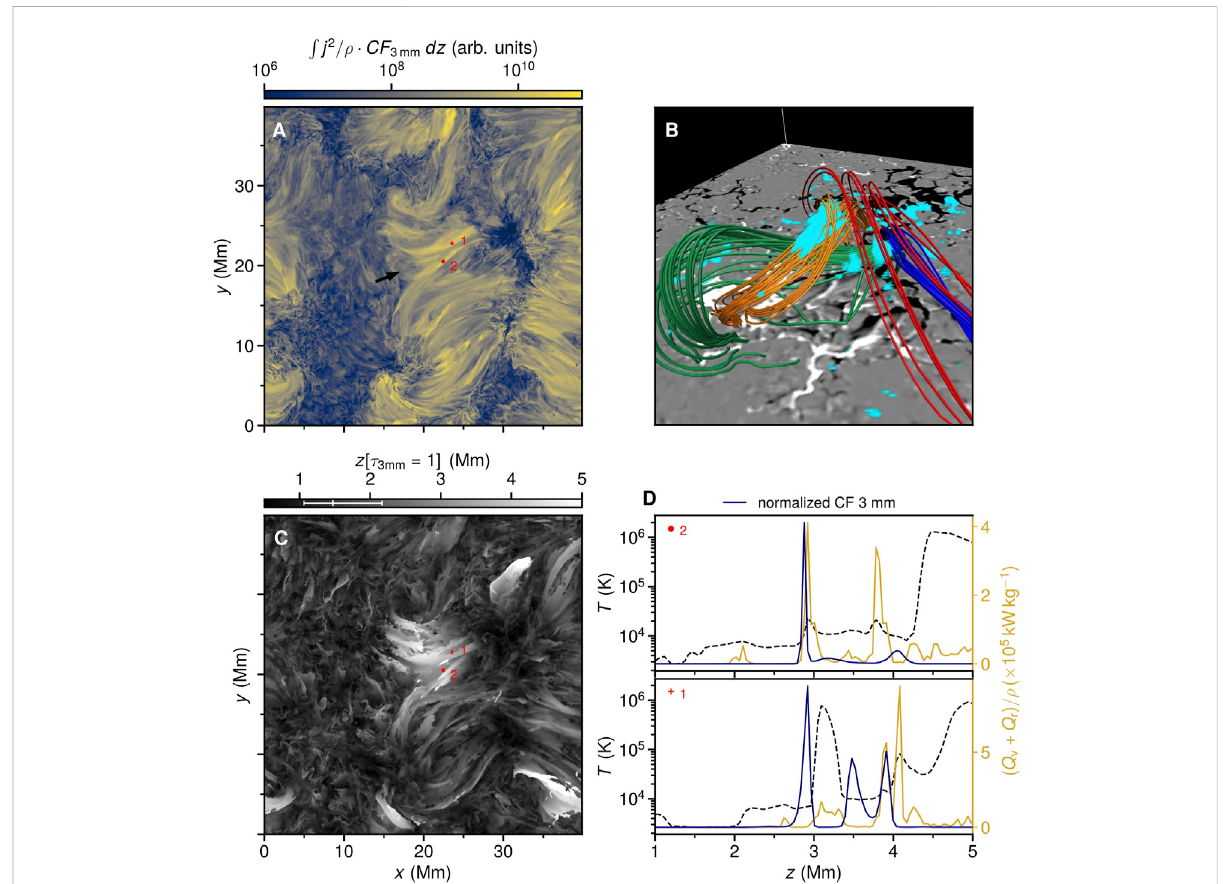
FIGURE 9 (A) Integrated j 2 / ρ weighted by the contribution function of the Band 3 emission (CF3mm); (B) Extrapolated magnetic fi eld lines overlying photospheric magnetogram with the CF3mm depicted with blue shade from the region indicated by the arrow in (A) ; (C) heights of formation of the Band 3 emission; (D) temperature (dashed lines), total heating rates per mass (yellow lines), and normalized CF3mm (dark blue lines) as a function of height at two locations indicated in (A) and (C) . From da Silva Santos et al. (2022a). Reproduced with permission ⓒ